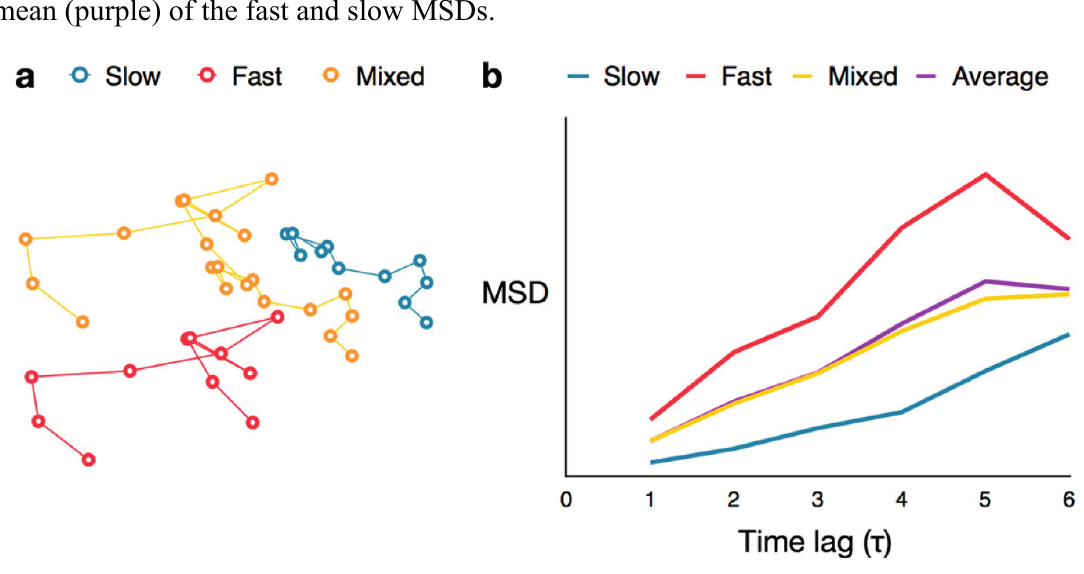
Figure 11. MSD averaging effect. ( a ) Three simulated trajectories for molecules exhibiting fast diffusion (red) and slow diffusion (blue), and a combination of the two (yellow), respectively; ( b ) MSD curves for the three trajectories in ( a ), as well as the curve for the mean (purple) of the fast and slow